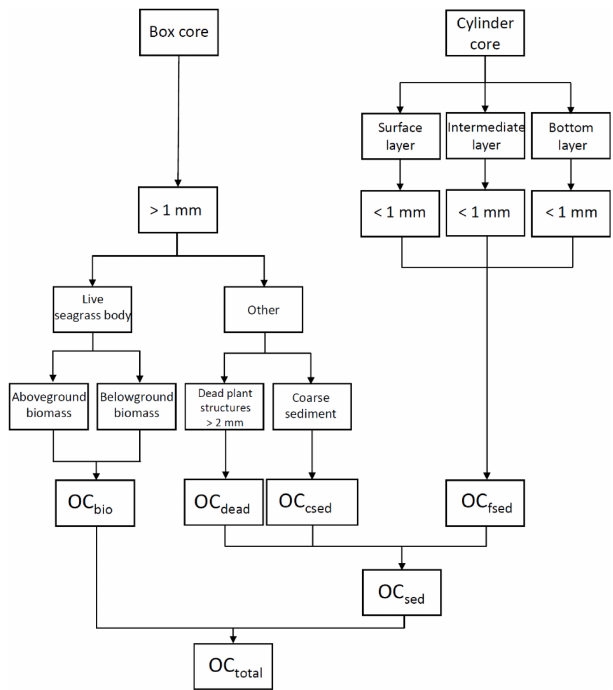
Figure 3. Calculation of total OC mass (OC total ; gCm − 2 ) in the top 0.15m layer. OC sed is sedimentary OC, OC bio is OC in live seagrasses, OC dead is OC in dead plant structures (>2mm in size: dead seagrass leaves, sheaths, rhizomes, and roots detached from live structures), OC csed is OC in the coarse (>1mm diameter) sedi- ments (excluding dead plant structures>2mm in size), and OC fsed is OC in the fine (<1mm diameter) sediments (including dead plant structures<1mm in